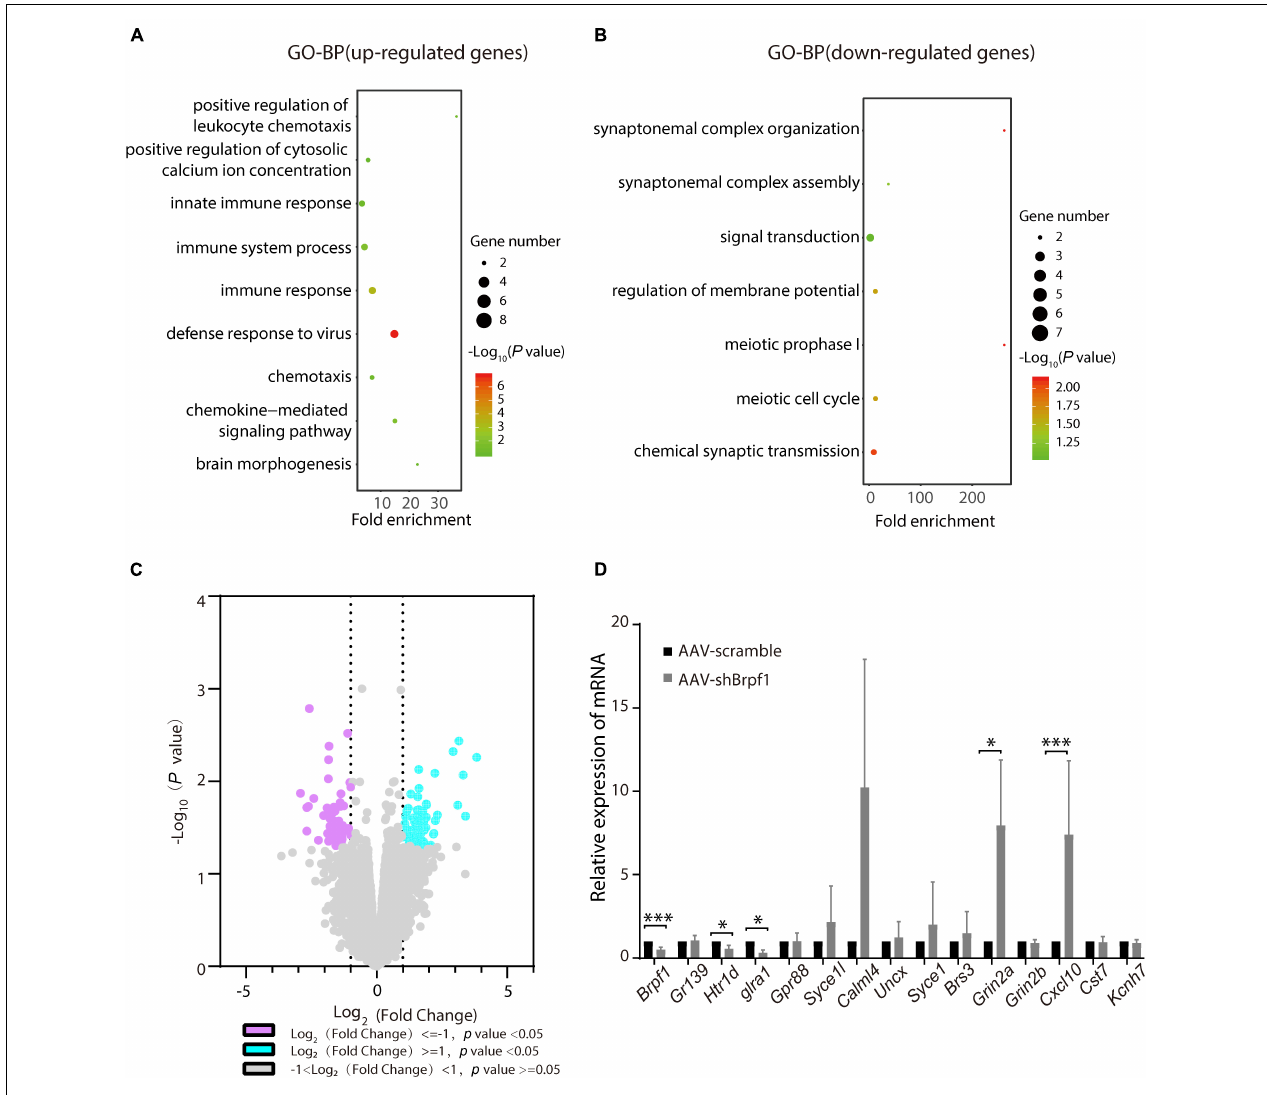
FIGURE 5 | Hippocampus-specific knockdown of Brpf1 regulated the expression of genes related to synaptic function. (A,B) Bubble plots represented GO-BP of upregulated genes [log 2 (fold change) ≥ 1 and p < 0.05] and downregulated genes [log 2 (fold change) ≤ –1 and p < 0.05] derived from mRNA-Seq analysis of three pairs of stereotactic injected CA1 tissue, respectively. Dot size reflected gene number; color indicated –log 10 P. (C) Volcano plot of DEGs from mRNA-Seq similar to (A,B) . (D) Selected DEGs were validated by RT-qPCR (AAV-scramble group, n = 3 mice; AAV-shBrpf1 group, n = 3 mice). ∗ p < 0.05, ∗∗∗ p <